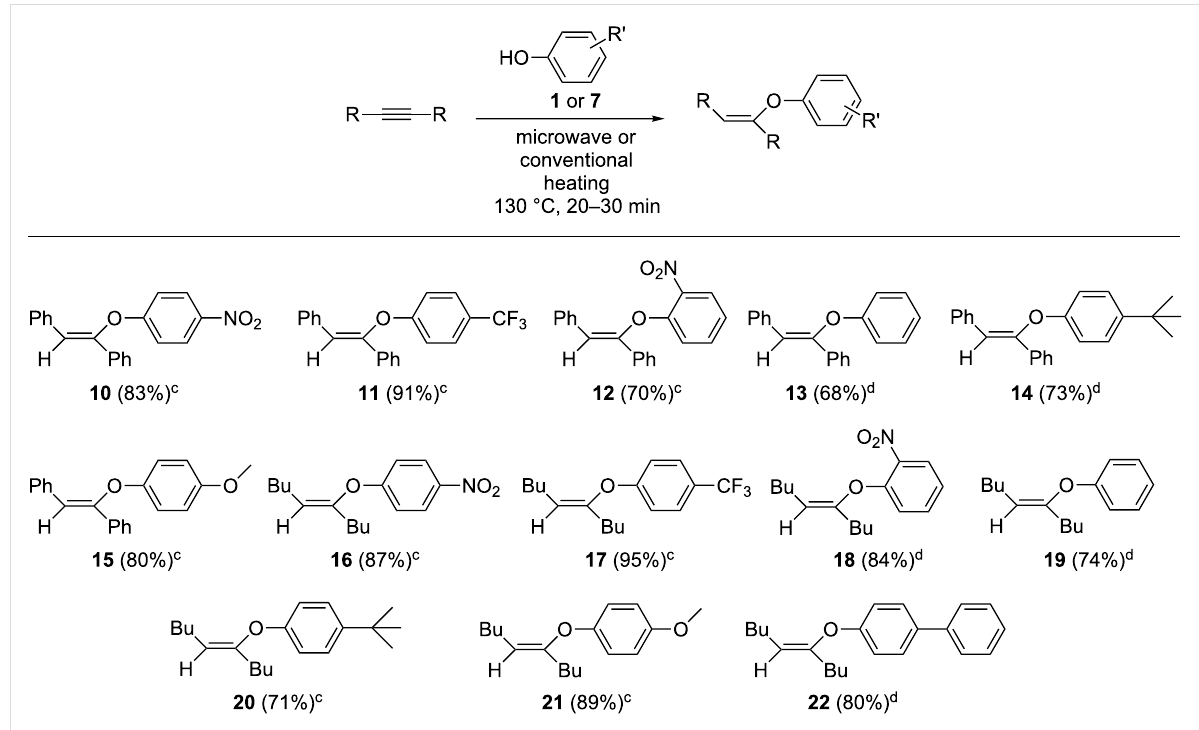
Figure 2: Hydrophenoxylation of alkynes a,b . a Alkyne (0.28 mmol), phenol (0.56 mmol), 130 °C, 20 min, no solvent. b Isolated yields. c Microwave heating with 1 as the catalyst (14.0 μ mol, 5%). d Conventional heating with 7 as the catalyst (14.0 μ mol, 5%).